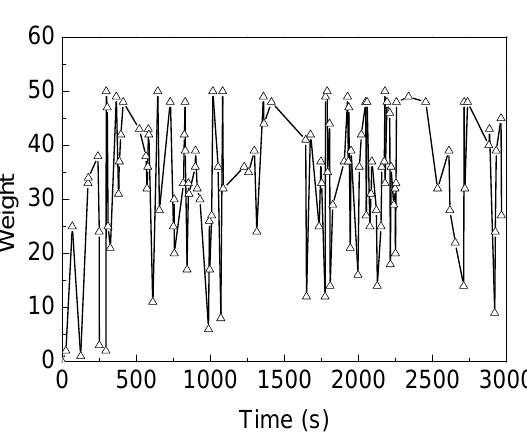
Figure 3. Sum of weight for